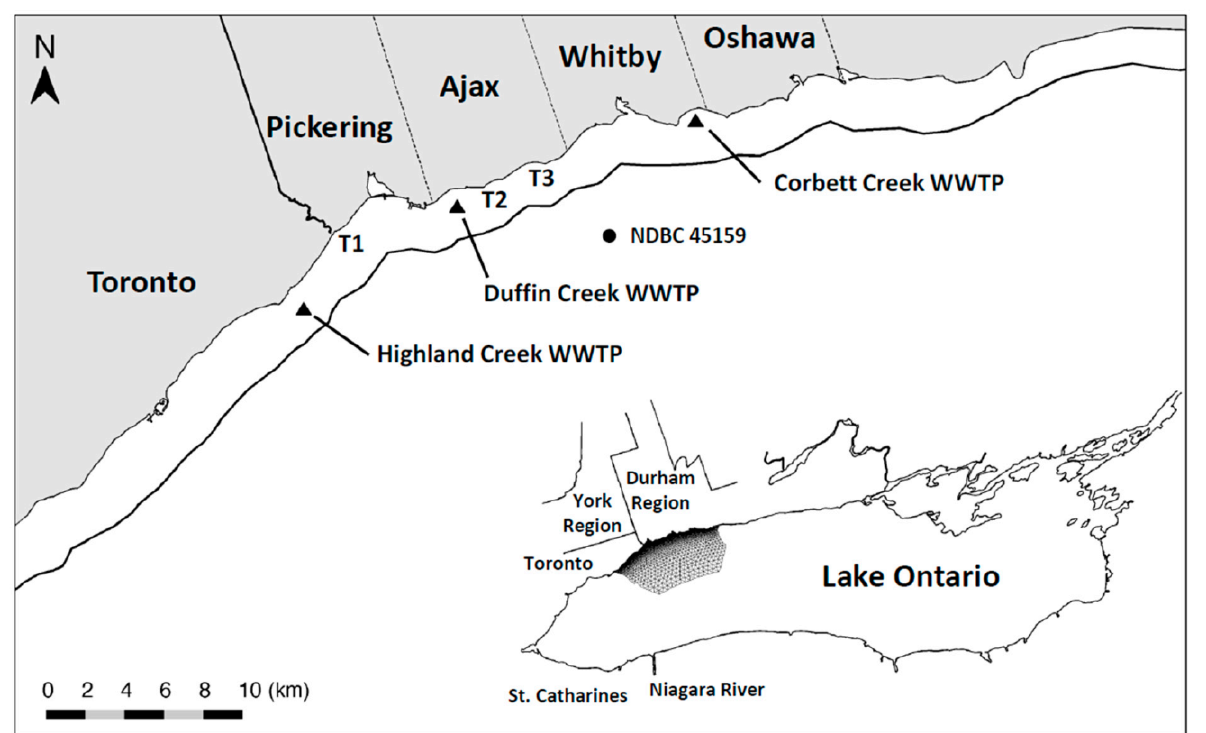
Figure 1. Study site and modeling domain along the Lake Ontario nearshore, centered on Pickering, Ajax and Whitby ON. Triangles identify the location of in-lake wastewater treatment plant discharges. Tributary entry to Lake Ontario is indicated as T1 (Rouge River), T2 (Duffins Creek) and T3 (Carruthers Creek). The solid line represents the 20 m depth contour, the approximate offshore limit to colonization by Cladophora . The inset includes the position of the study site model grid within the whole-lake grid used in hydrodynamic simulations. The locations of the Regional Municipalities of York and Durham, containing the area served by the Duffin Creek wastewater treatment plant are indicated in the inset as